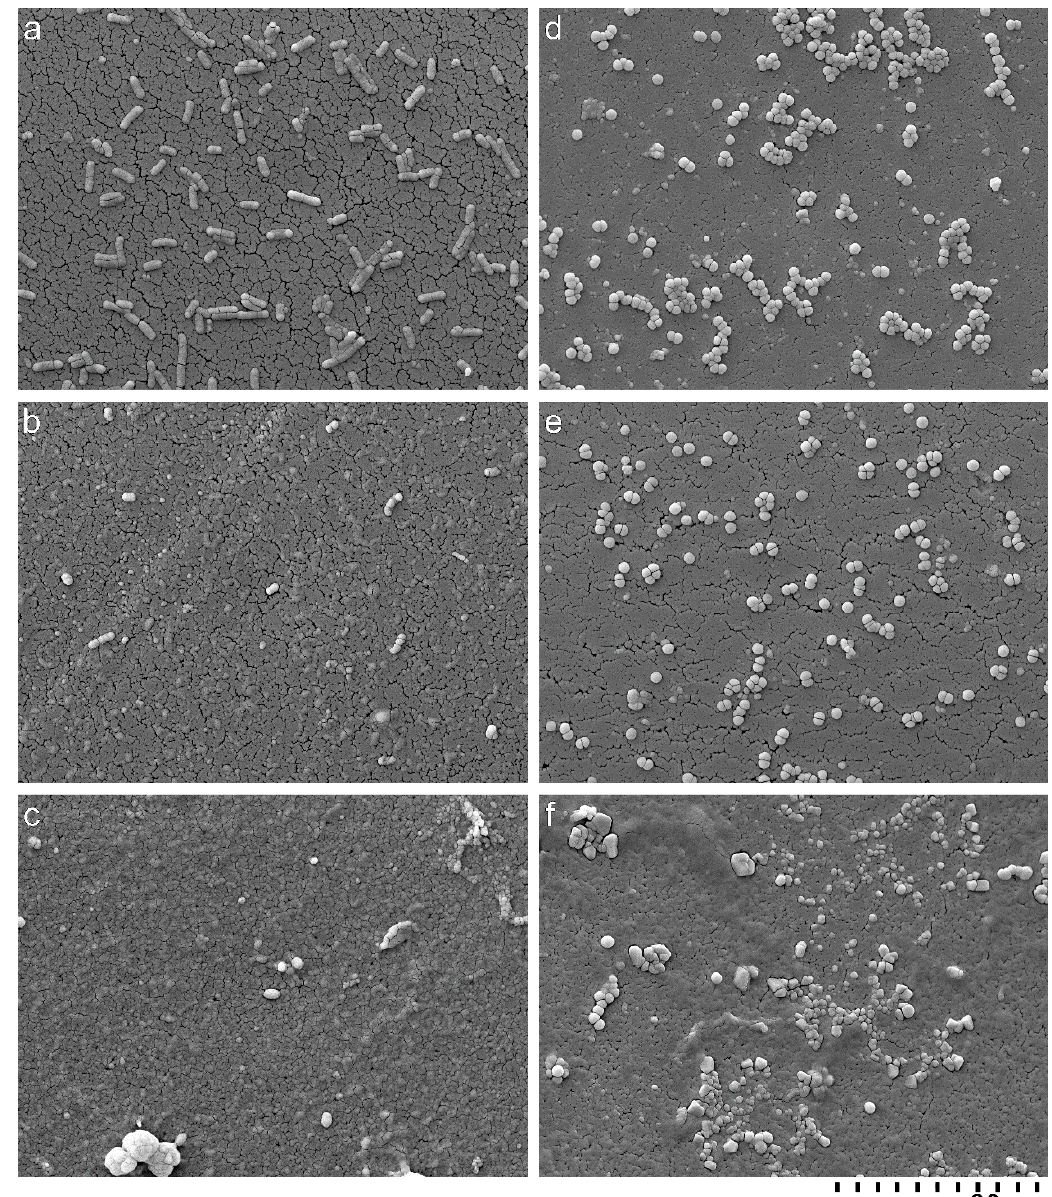
Figure 5. Scanning electron microscope (SEM) images from overnight cultures of E. coli ( a – c ) and S. aureus ( d – f ). Bacteria suspensions incubated without peptides ( a , d ), incubated with 128 µ g / mL PMB ( b , e ), and incubated with 128 µ g / mL AMP (LF11-322-C 8 ) ( c , f ).